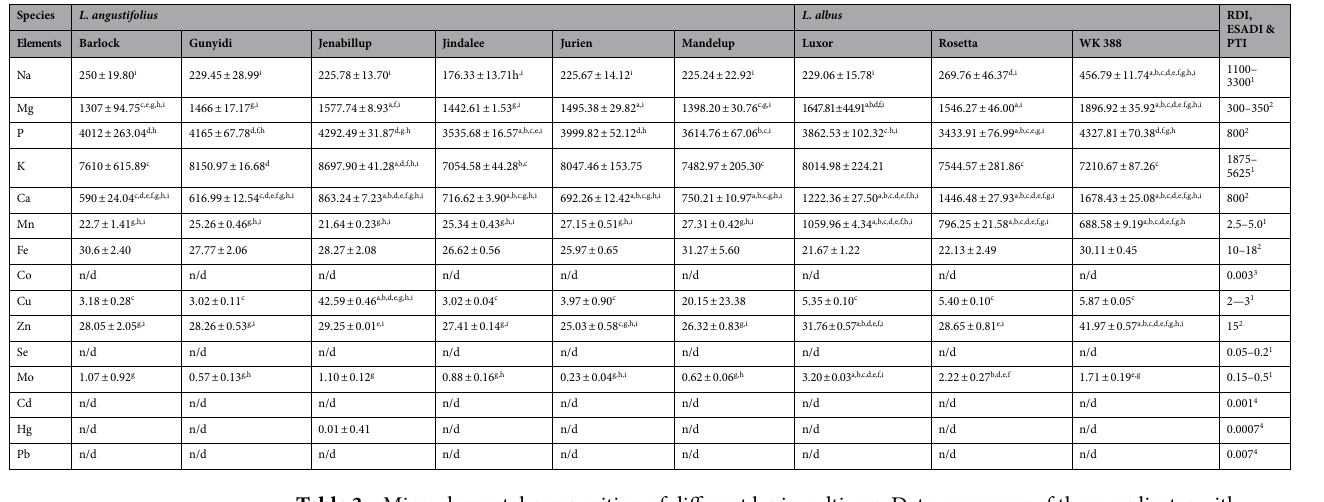
Table 3. Microelemental composition of different lupin cultivars. Data are means of three replicates with standard deviations (SD) and is expressed as mg/kg dry weight; n/d (not detected, below the detection level). Data within the same row with different superscripts are significantly different, pair-wise comparison by Post Hoc Tukey test ( a P < 0.05 vs. Barlock; b P < 0.05 vs. Gunyidi; c P < 0.05 vs Jenabillup; d P < 0.05 vs. Jindalee; e P < 0.05 vs Jurien; f P < 0.05 vs. Mandelup; g P < 0.05 vs Luxor; h P < 0.05 vs Rosetta; i P < 0.05 vs WK388). 1 Estimated Safe and Adequate Dietary intake (ESADI); 2 Reference daily Intake (RDI); 3 expressed as weight of vitamin B12; 4 provisional tolerable intakes (PTI) expressed as mg/kg body